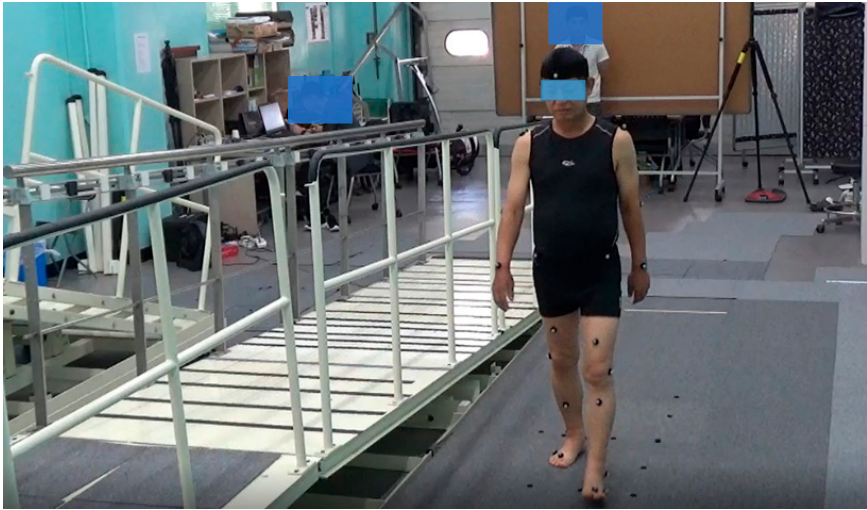
Figure 2. Motion capture analysis environment.